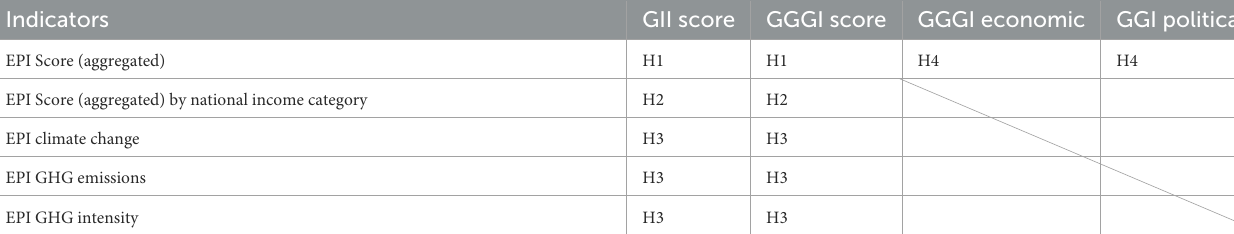
TABLE 2 Correlations performed in the quantitative analysis, and the hypothesis tested. Indicators GII score EPI Score (aggregated) EPI Score (aggregated) by national income category H2 H2 EPI climate change H3 EPI GHG